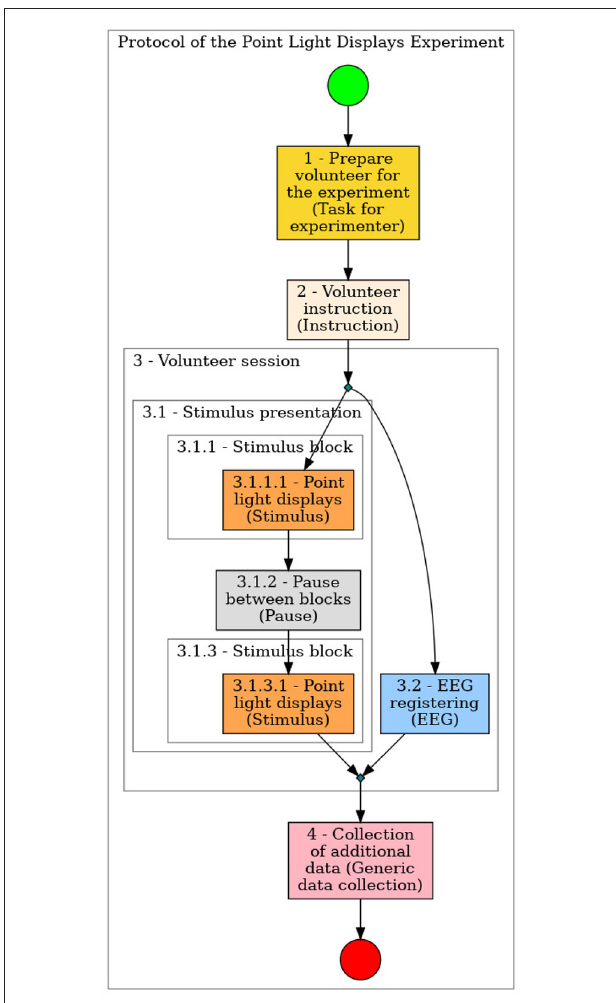
FIGURE 9 | Example of diagram generated by NES from an experimental protocol